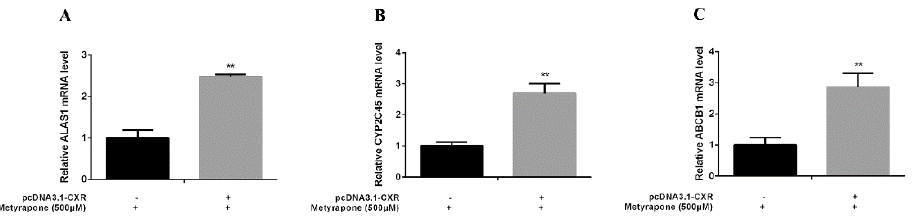
Figure 4. RT-PCR analysis of ALAS1 ( A ), CYP2C45 ( B ) and ABCB1( C ) mRNA levels in chicken pri- mary hepatocytes transfected with a CXR expression vector and then treated with 500 μM metyrapone for 24 h. Bars show means ± SD of three independent experiments. ** p < 0.01, compared with the control group.